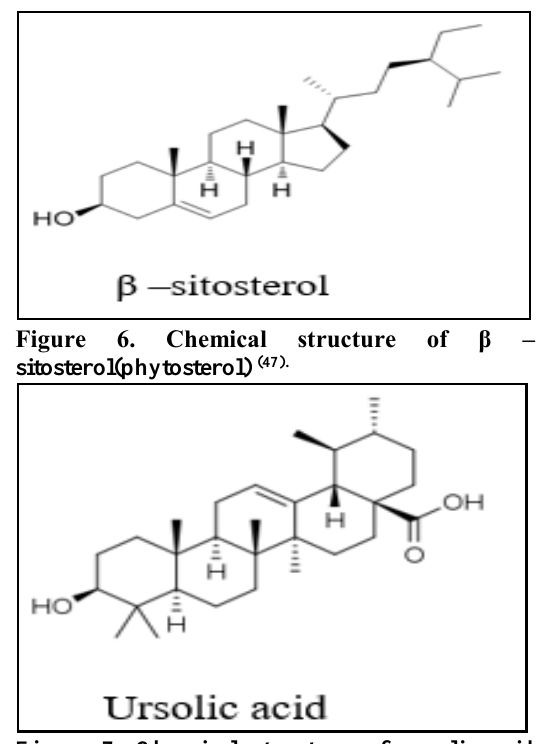
Figure 7. Chemical structure of ursolic acid (pentacyclic triterpenoids) (48)